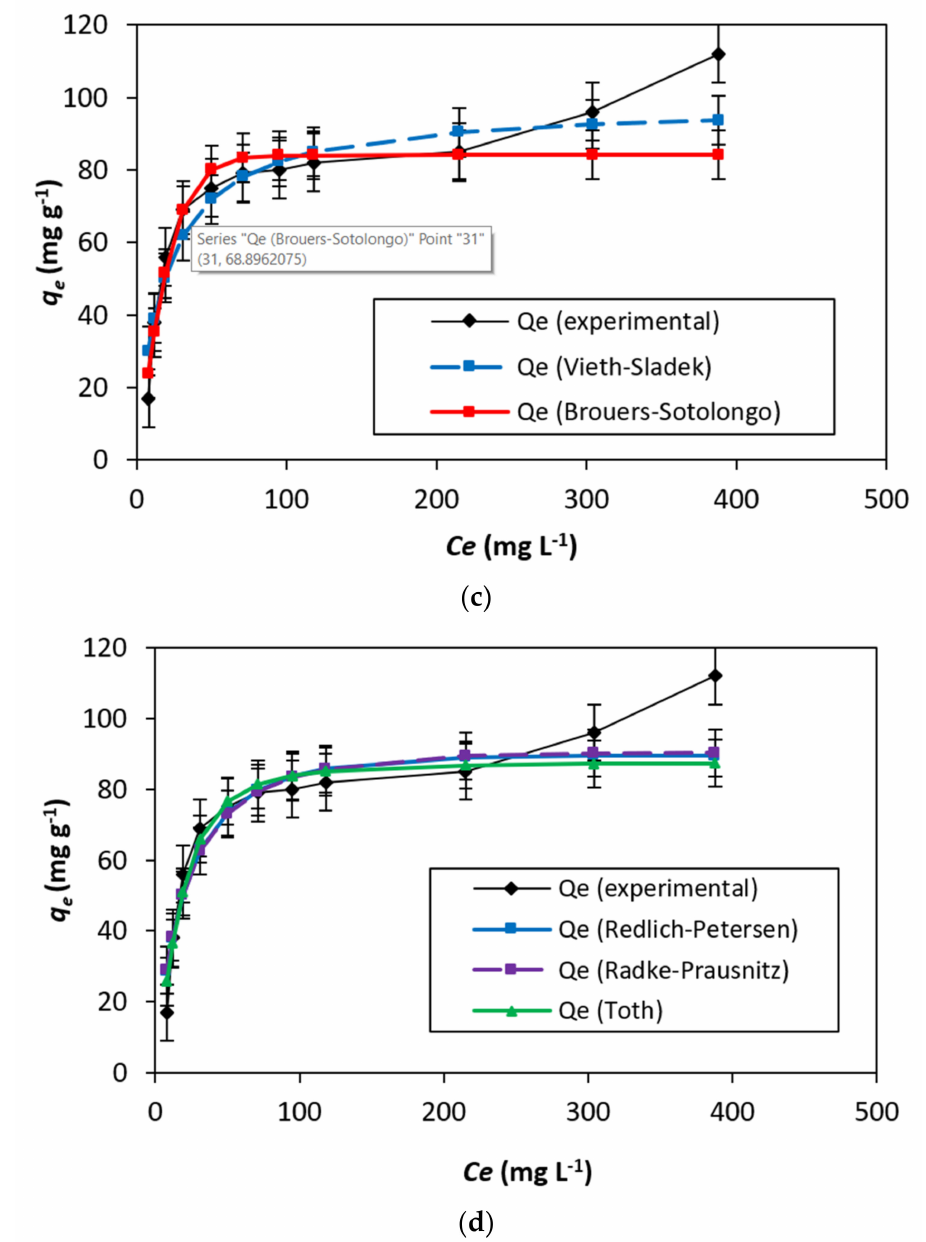
Figure 7. ( a – d ) The curve fitting was conducted on adsorption data isotherm for DB15–HNT. Table 2. Two-parameter isotherms. Two Parameter Isotherms Langmuir Freundlich Jovanovic